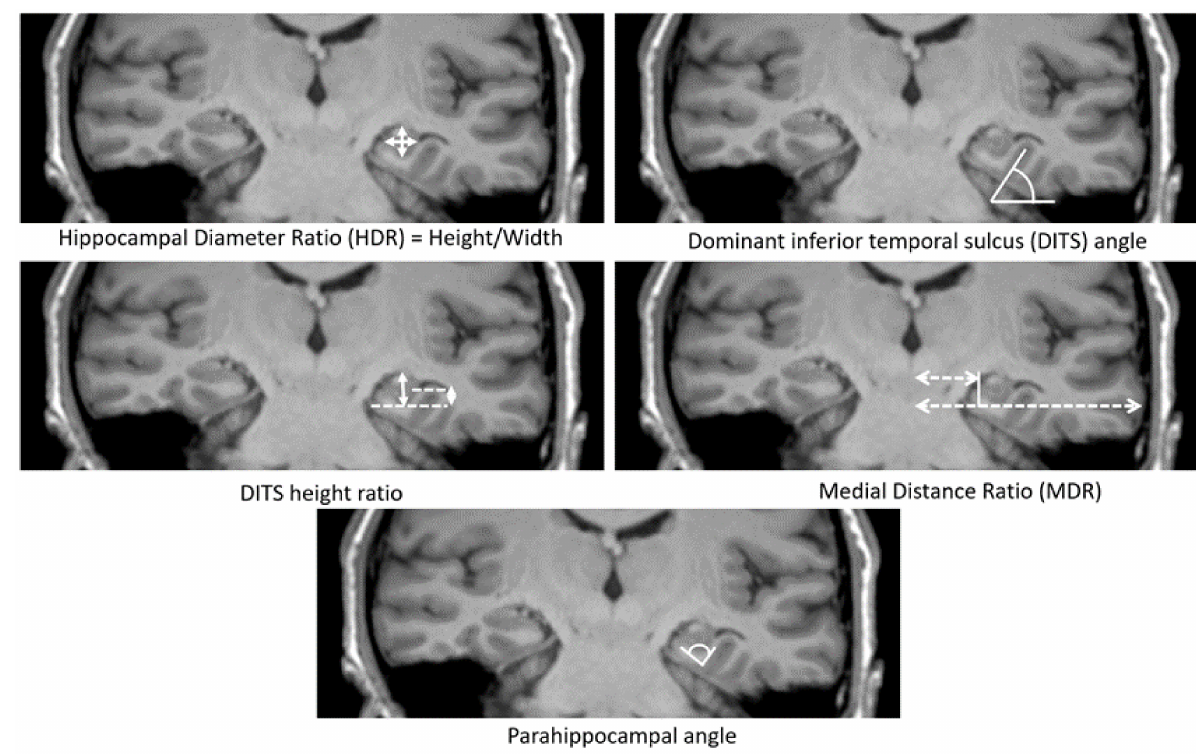
Figure 2. Quantitative assessments of medial positioning and vertical orientation of hippocampus. Figure 2 Legend: Hippocampal diameter ratio (HDR) was calculated by measuring the height and width of hippocampal. This represents the shape change of HIMAL; the normal hippocampus usually has a smaller ratio than HIMAL. Dominant inferior temporal sulcus (DITS) refers to the predominant sulcus of the inferior temporal surface, either collateral sulcus (CS) or occipitotemporal sulcus (OTS). This is because there are variations among individuals; some have very shallow CS, and the predominant sulcus is OTS instead. DITS angle was the angle of the sulcus from the horizontal line, which represents the verticalization of DITS. DITS height ratio was the height from the inferior margin of the hippocampus to the superior margin of the DITS divided by the total hippocampal height. The DITS height ratio represents the deep sulcus that protrudes to an empty temporal horn. The medial distance ratio (MDR) was calculated by measuring the distance between the midline and the fimbria divided by the total distance from the midline to the temporal neocortex passing through the temporal horn of the lateral ventricle. MDR represents the medial localization of the hippocampus. Parahippocampal angle (PHA) was calculated by measuring the angle between the descending and ascending portion of the parahippocampal gyrus. PHA also represents the shape change of the hippocampus (Figure adapted from